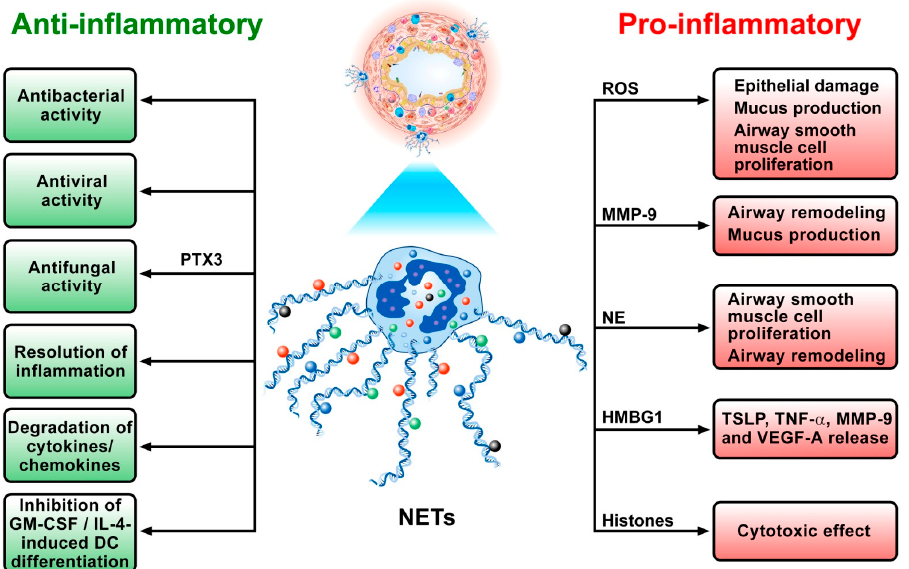
Figure 3. Schematic representation of the pleiotropic and potentially conflicting roles of NETs in human and experimental models of asthma. NETs and their components can exert a pathogenic role in asthma. In particular, they can contribute to epithelial and endothelial damage mediated by ROS, MMP-9 or NE [174]. ROS and NE can also favor airway smooth muscle cell proliferation [175]. MMP- 9 contributes to airway edema and remodeling [112] and, together with ROS, stimulates mucus pro- duction [176]. High-mobility group box 1 protein (HMBG1) induces the release of TSLP, TNF- α , MMP-9 and VEGF-A from bronchial epithelial cells [150]. Histones exert a cytotoxic effect [177], and MMP-9 and NE participate in airway remodeling of the extracellular matrix (ECM) [178]. In an ex- perimental model, NETs promoted rhinovirus-induced type 2 asthma exacerbations [139]. Neutro- phil cytoplasts induced T H 17 differentiation in a non-type 2 model of asthma [179]. NETs